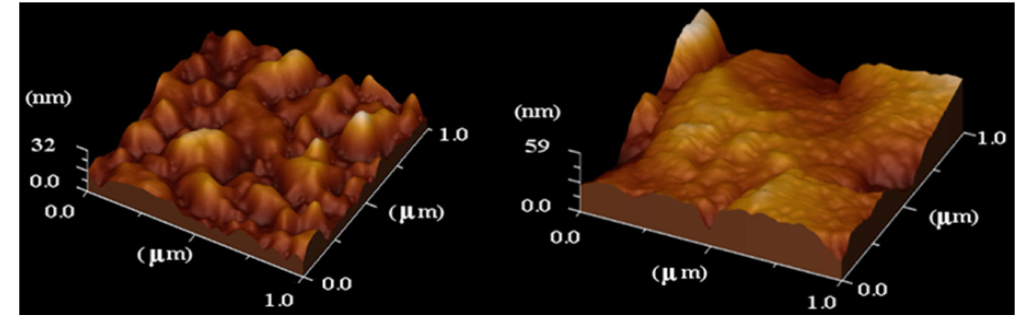
Figure 14. 3D AFM micrographs with ten monolayers for 2b and 4b films, respectively.